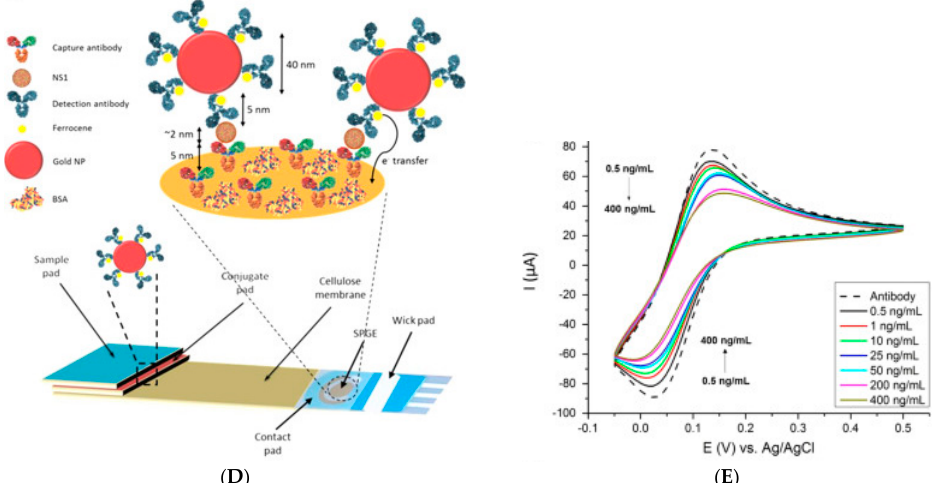
Figure 22. ( A ) ( a ) Scheme of the cells biorecognition with AuNPs-conjugated antibodies and detection through the electrocatalyzed HER; ( b ) CVs performed from +1.35 to − 1.40 V at a scan rate of 50 mV/s in 1 M HCl in the absence (a curve) and in the presence (b curve) of AuNPs-conjugated antibodies; ( c ) Left: Chronoamperograms registered in 1 M HCl, during the HER applying a constant voltage of − 1.0 V, for AuNPs-labeled cells (a: control with BSA; b: 3.5 × 10 4 cells). Right: Comparison of the corresponding analytical signals for the blank and the positive sample. Reprinted from [117], Copyright © 2012 WILEY-VCH Verlag GmbH & Co; ( B ) EIS immunosensor based on AuNPs for detection of HbA1c; ( C ) Impedance change with the concentration of target anti-HbA1c IgG (triangle dot), anti-biotin antibody (square dot), and anti-pig IgG (circle dot). Adapted from [118]